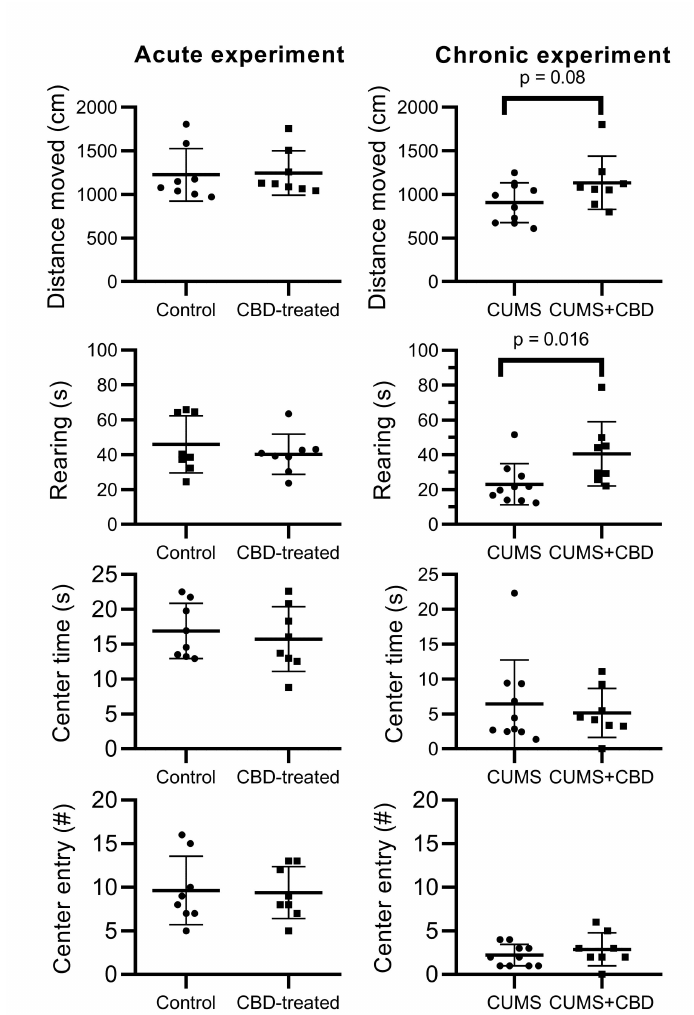
Figure 5. Results of the open field test in the two experiments. The first column represents the acute experiment, where non-stressed animals received a single dose of vehicle or 10 mg / kg of CBD. The second column shows the chronic experiment, where the animals were treated for 32 days with vehicle or 10 mg / kg of CBD and were subjected to the CUMS protocol. Means ± SEM (n = 8–10) are presented. Data were analyzed with unpaired t -test or Mann–Whitney test. The dots represent individual values, * p <